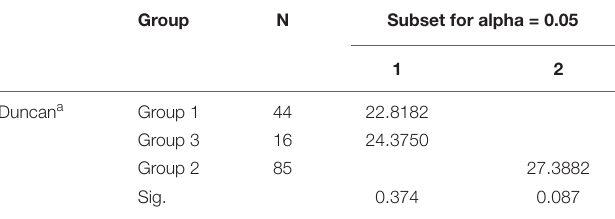
TABLE 4 | Post-Hoc test showing significant difference among group 1, group 2, and group 3 on basis of verbal aggression. Group N Subset for alpha =